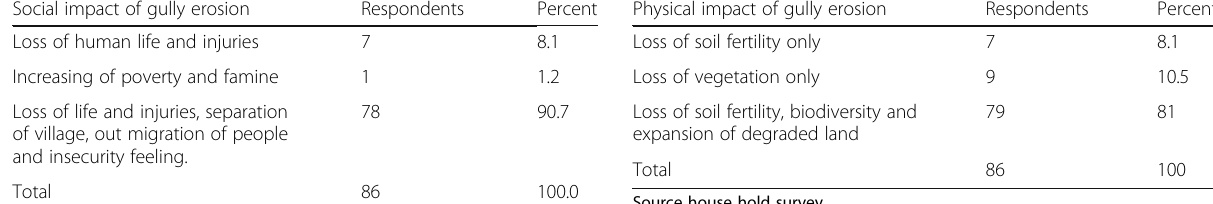
Table 9 Social effect of gully erosion Social impact of gully erosion